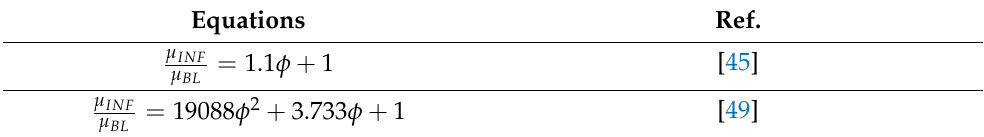
Table 6. Empirical correlations of effective viscosity of ILs-based nanofluids. Equations